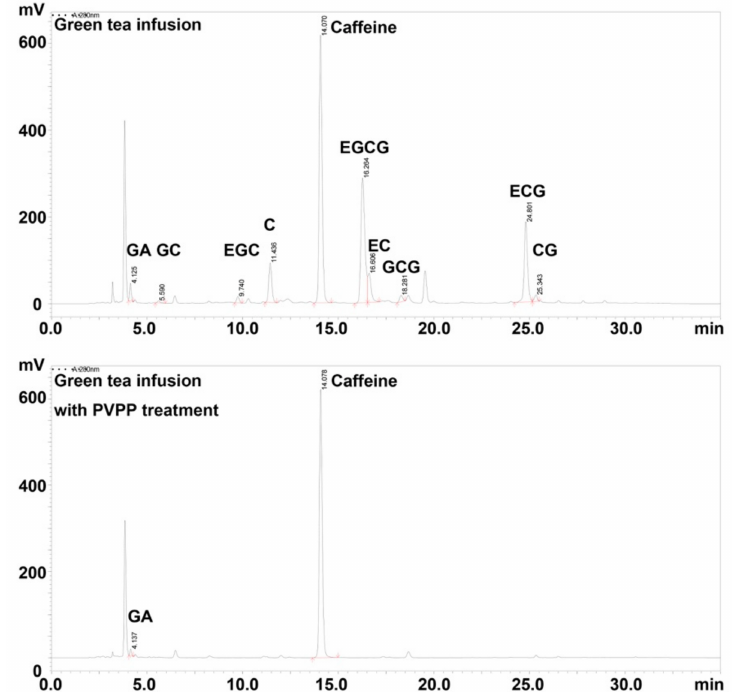
Figure 5. HPLC spectrums of catechins in green tea infusion with and without olyvinylpolypyrroli- done (PVPP)